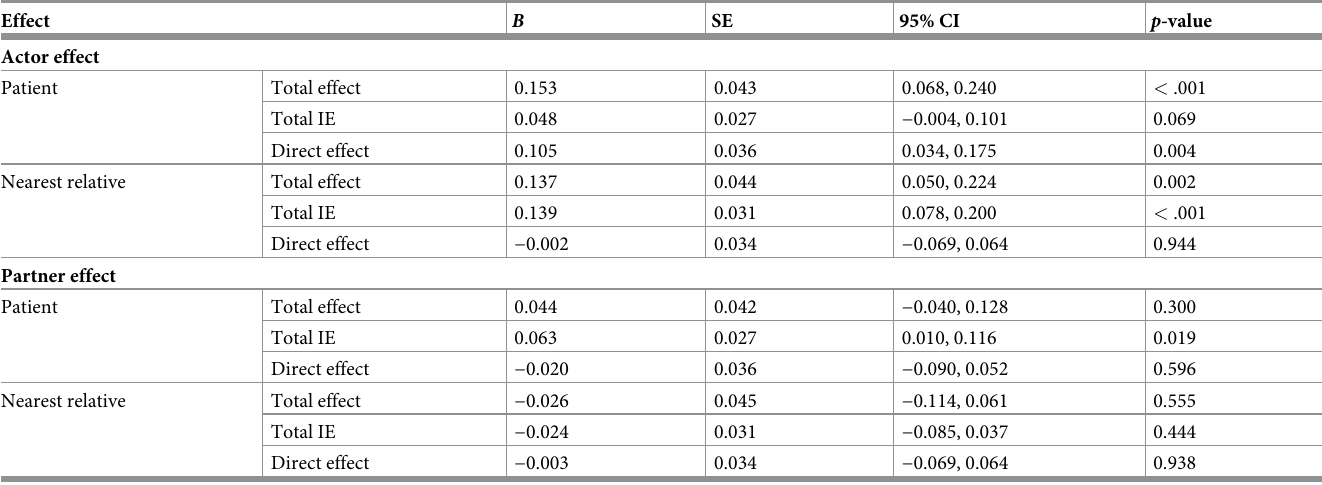
Table 4. The total effects, total indirect effects, and direct effects in the APIMeM in patients with heart failure (n = 312) and their nearest relatives (n =